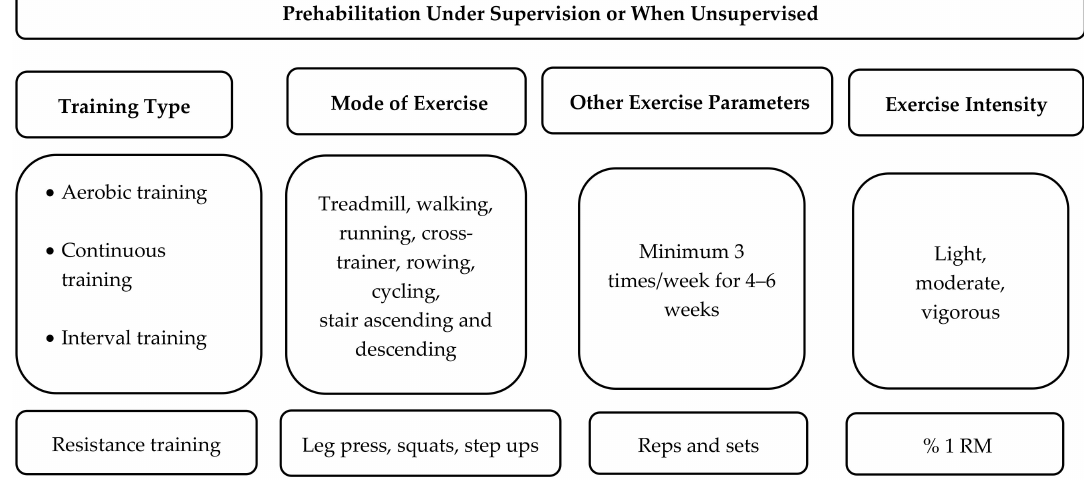
Figure 1. Diagram illustrating the key components of a prehabilitation programme for abdominal cancer patients. Training types include aerobic and resistance training using a variety of modes of exercise performed at light to moderate intensity at least three times per week. These exercises can be performed in a supervised or unsupervised setting. Note: Repetition maximum